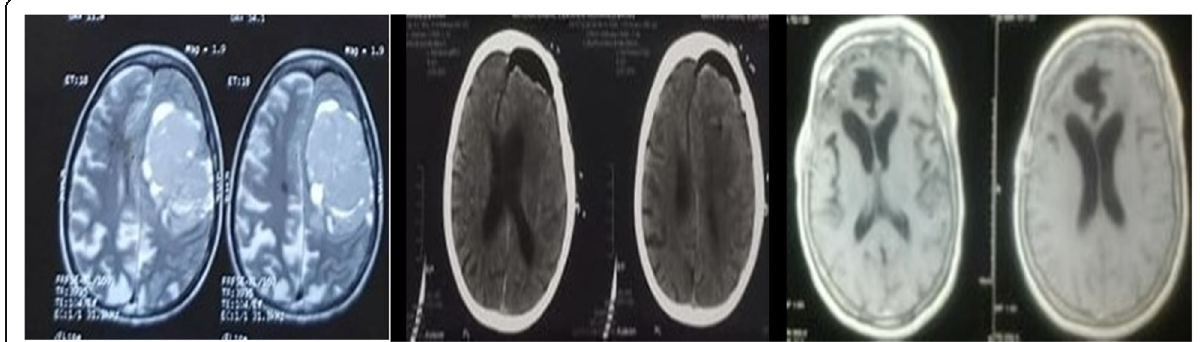
Fig. 6 Left convexity meningioma. Left, preoperative axial MRI TII. Middle, CT brain done in the 2nd postoperative day with no residual. Right image, axial MRI TI image done 2 years after surgery with no